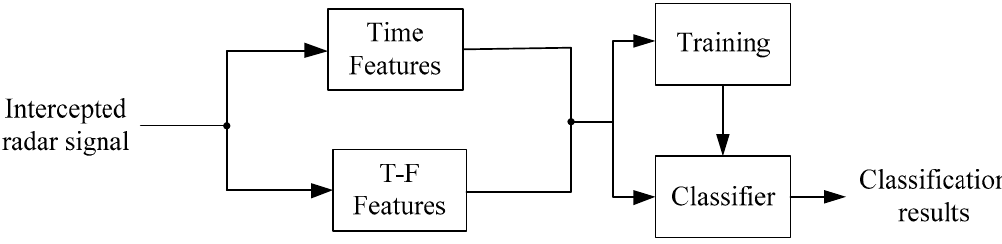
Figure 1. The structure of classification system is displayed in this figure. It is formed by time features, T-F features and classifier.